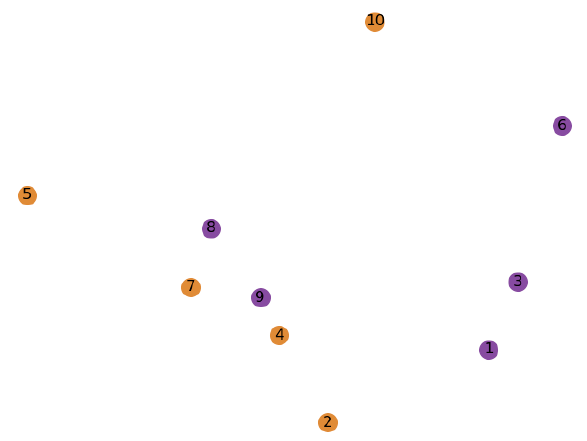
Figure 12. Quasi-Cliques of the Slovene Parliament.